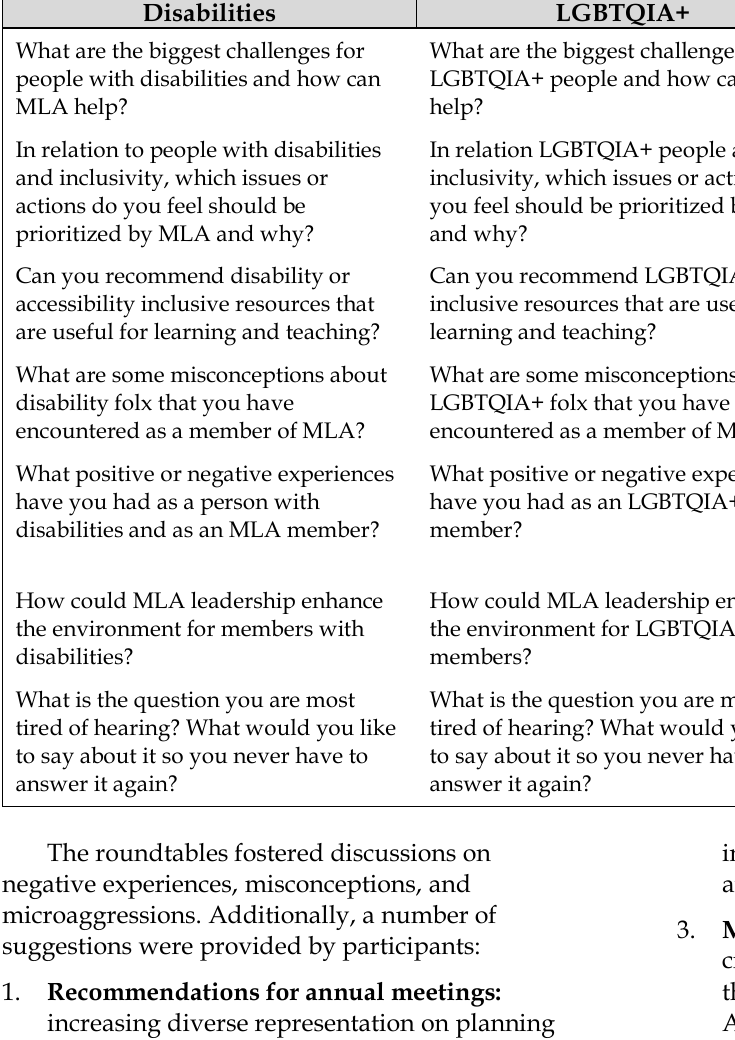
Table 2 Diversity Dialogues roundtable